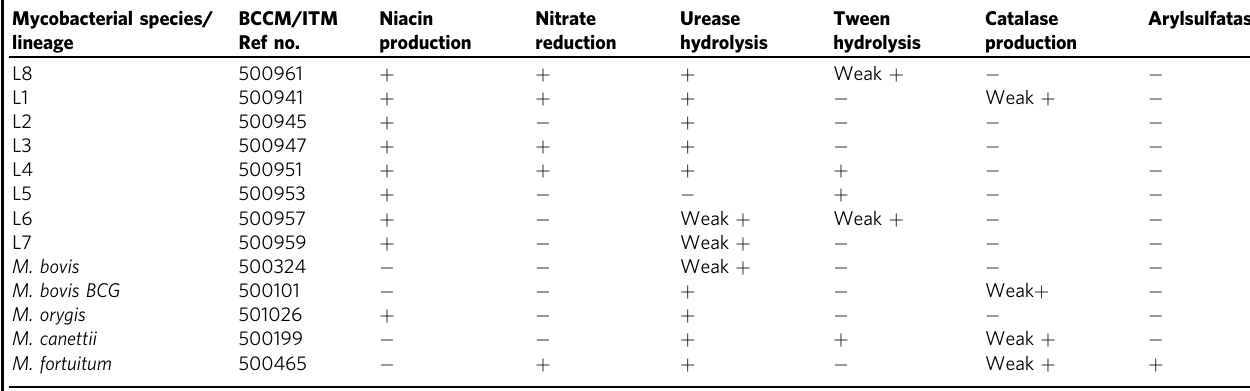
Table 1 Standard biochemical characteristics of selected mycobacterial species and M. tuberculosis complex lineages/